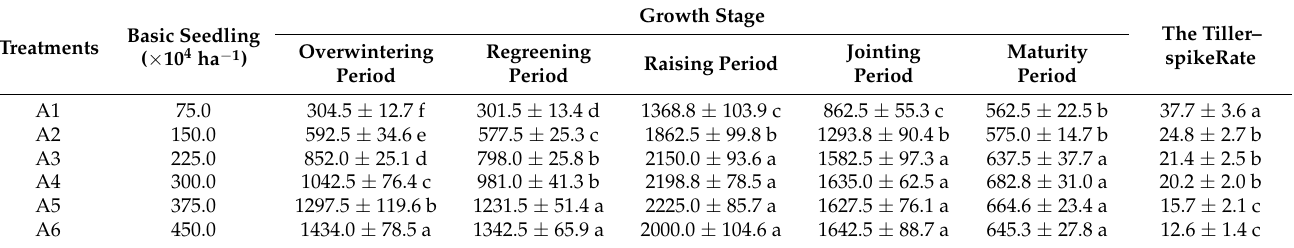
Table 2. Dynamics of wheat plant population quantity in different densities ( × 10 4 ha − 1